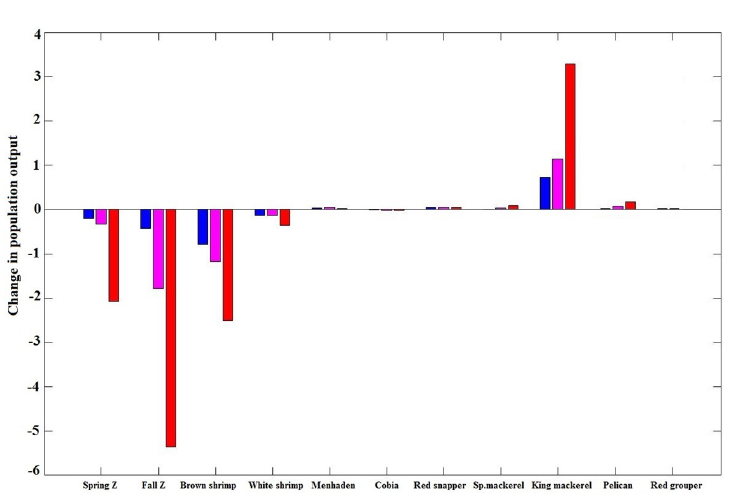
Fig 6. Change in population output. Mean difference of change between the estimated population outputs of the DDDBN model and SST scenarios: increase of 1.0˚C (blue), 1.5˚C (purple) and 3.0˚C